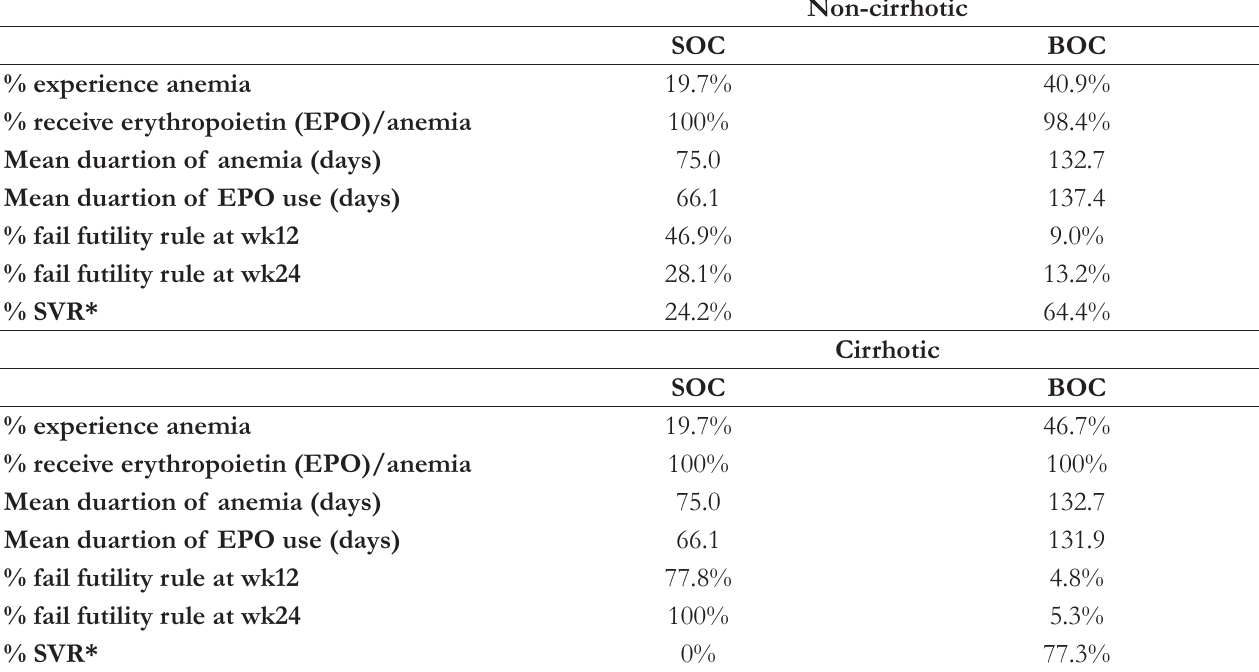
Table 3. Treatment Outcomes in the Treatment-experienced